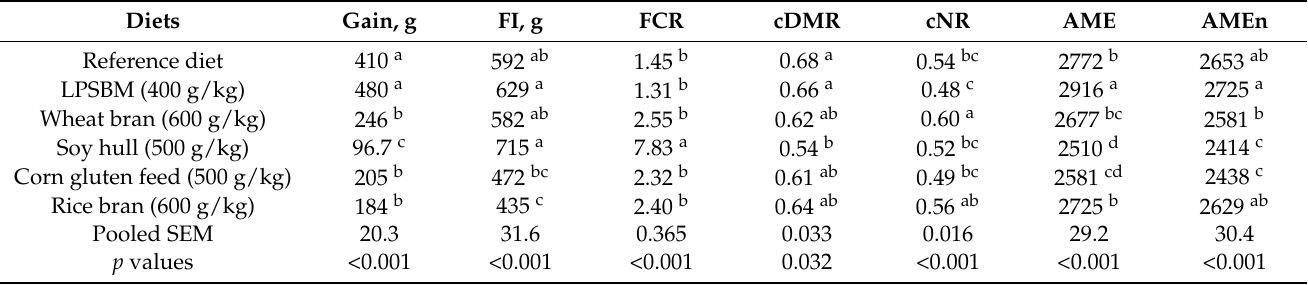
Table 5. Growth performance (day 14 to day 21), coefficients of total tract retention, and dietary metabolizable energy (kcal/kg) for broiler chickens in response to short-term feeding of high levels of high-protein or high-fiber feedstuffs in a corn–soybean meal reference diet during metabolizable energy